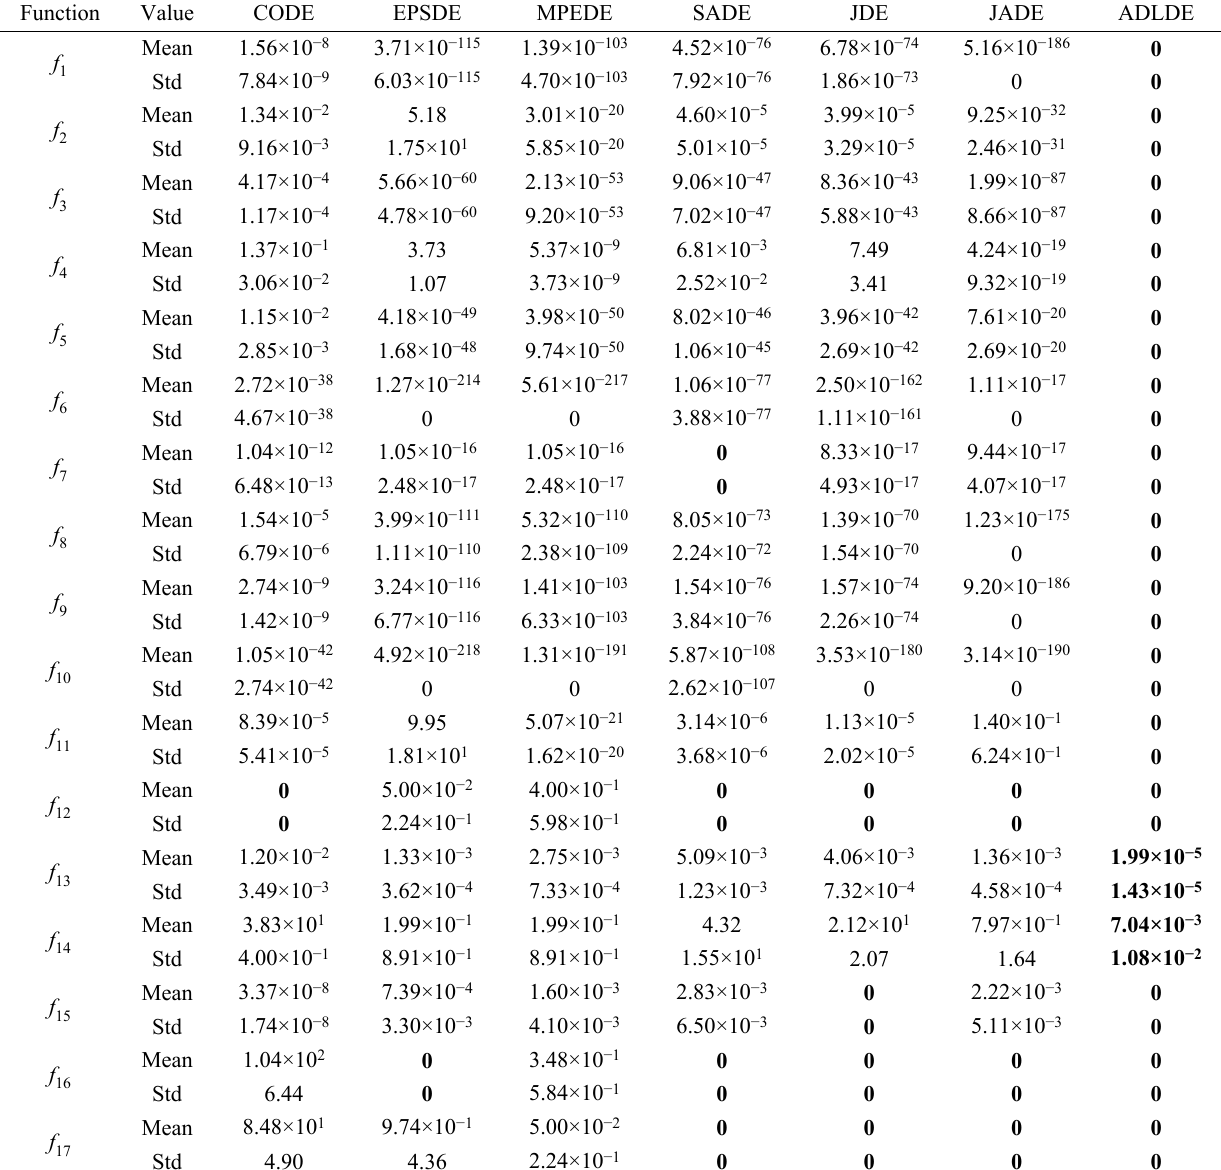
Table A4 Function error values of benchmark functions when D =